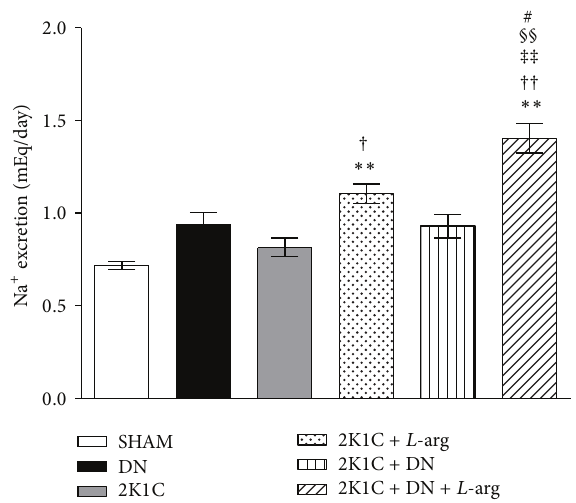
Figure 3: Urinary sodium excretion after oral L -arginine ( L -arg) administration to the SHAM, two-kidney one-clip, and denervated groups. The groups are as follows: SHAM: normotensive con- trol; 2K1C: two-kidney one-clip; 2K1C+ L -arg: two-kidney one-clip treated with L -arginine; DN: denervated normotensive; 2K1C+DN: denervated two-kidney one-clip; and 2K1C+DN + L -arg: dener- vated two-kidney one-clip treated with L -arginine. The data are shown for 7 days of L -arg administration. Data are reported as the means ± SEM. ∗∗ 𝑃 < 0.01 compared with SHAM; †† 𝑃 < 0.01 compared with DN; † 𝑃 < 0.05 and †† 𝑃 < 0.01 compared with 2K1C; # 𝑃 < 0.05 compared with 2K1C+ L -arg; 𝑃 < 0.05 compared with 2K1C+DN (Tukey